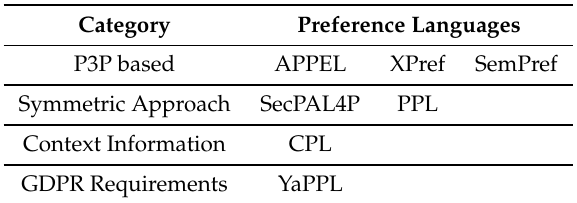
Table 6. Selection of preference languages from the literature categorised into P3P based languages, symmetric approaches which combine both a privacy language as well as a preference language into a single language and languages meeting modern requirements, like supporting mobile devices by introducing preferences for context information and meeting GDPR